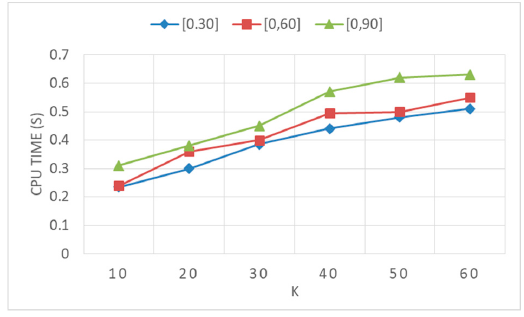
Figure 12. The number of nodes, edges, and moving objects in local road network with different K values.